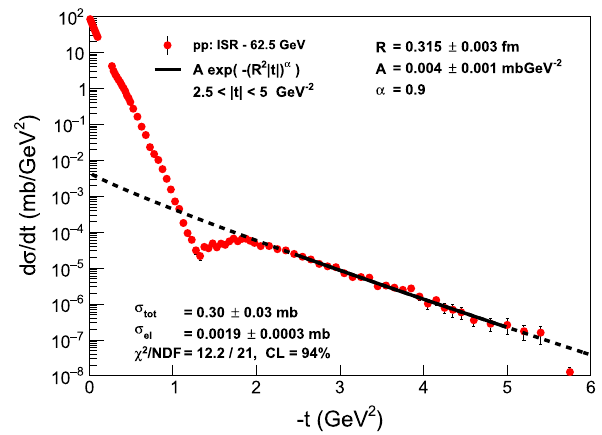
Fig. 35 Zeroth-order Lévy fits to the tail of the differential cross- √ s = 62 . 5 GeV [45], with section data on pp elastic scattering at liminary), with fixed α = 0 . 9, A and R as free fit